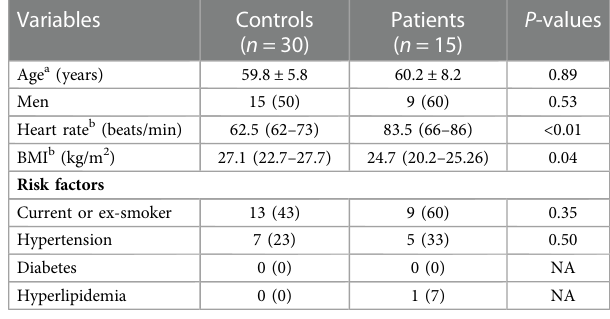
TABLE 1 Clinical characteristics of participants at baseline and healthy controls. Variables